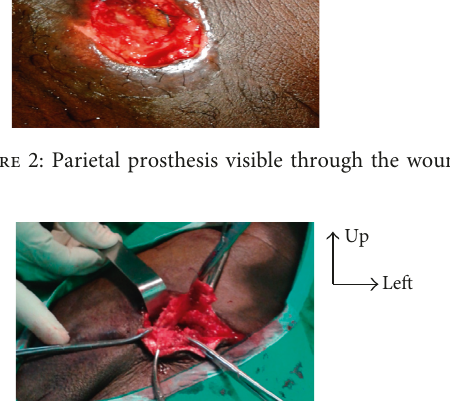
Figure 3: Ablation of the prosthesis via the inguinal channel.